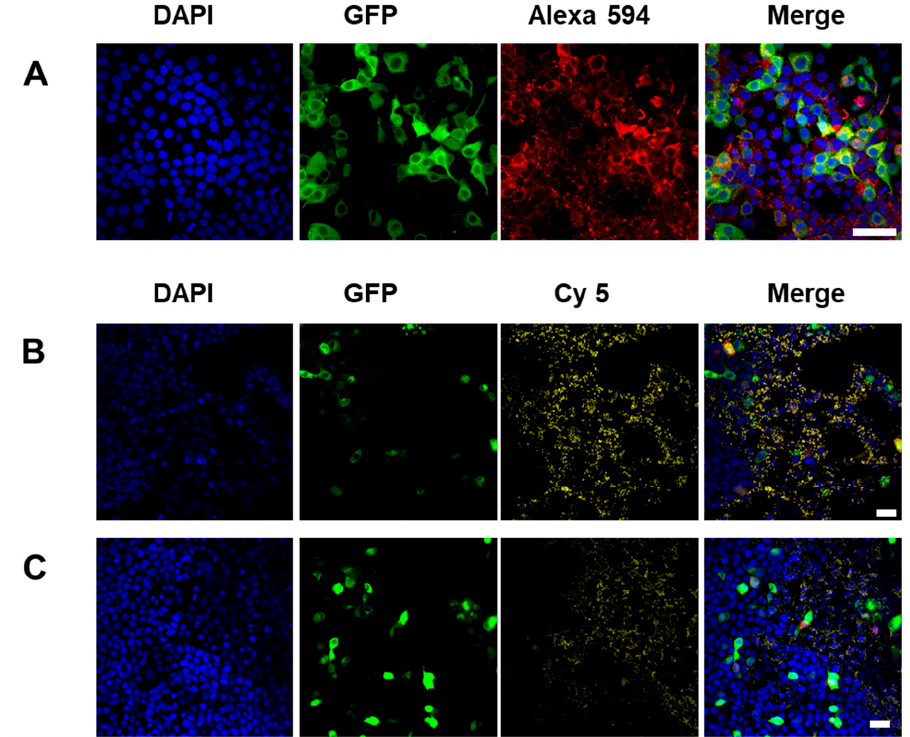
Figure 3. Images of HEK293T cells after the addition of magnetic particles. ( A ) Biotinylated HEK293T EPG+GFP cells with Alexa 594-conjugated streptavidin (×40). ( B ) HEK293T EPG+GFP cells with Cy5 HEK293T EPG + GFP cells with Alexa 594-conjugated streptavidin ( × 40). ( B ) HEK293T EPG + GFP cells conjugated ferromagnetic particles (×20). ( C ) HEK293T EPG+GFP cells with Cy5 conjugated superparamagnetic nanoparticles (×20, Blue: DAPI, Green: EPG+GFP, Yellow: Cy5; scale bar = 20 µm). superparamagnetic nanoparticles ( × 20, Blue: DAPI, Green: EPG + GFP, Yellow: Cy5; scale bar = 20 µ